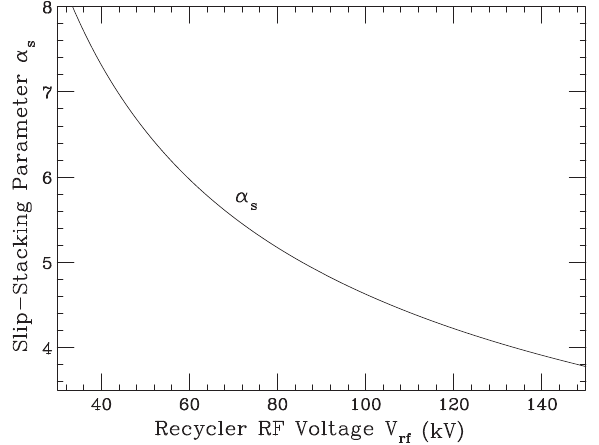
FIG. 2. The slip-stacking parameter α s versus the Recycler rf voltage V rf